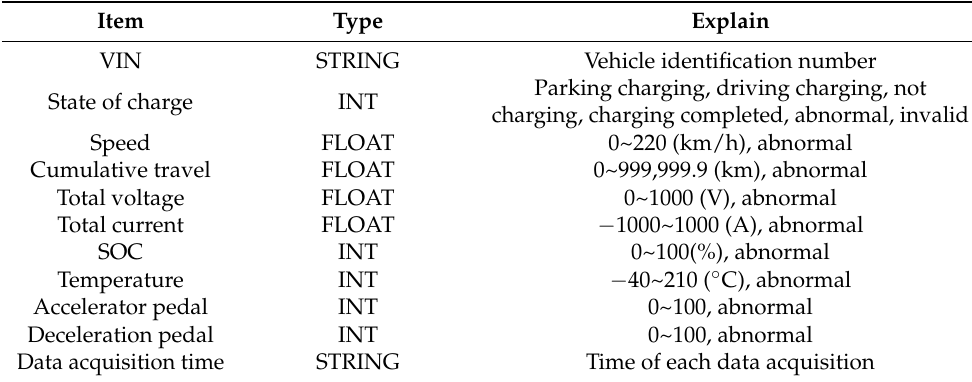
Table 1. A detailed description of the items used in this